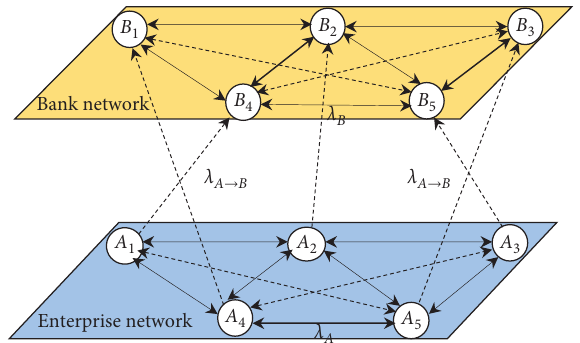
Figure 1: Credit risk transmission path of bank-enterprise counterparties without bank withdrawal loan.